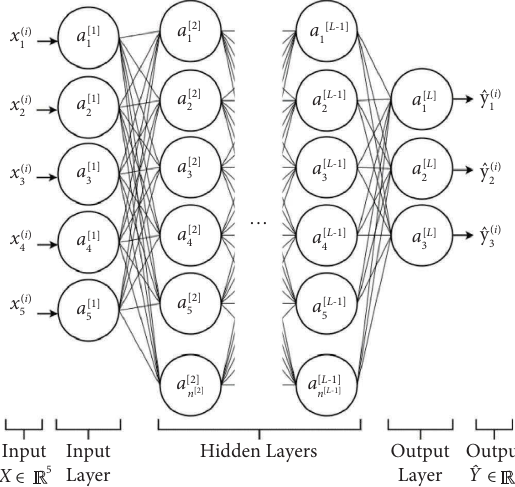
Figure 3: Te structure of the FCDNN as a positioning engine in an area with 6